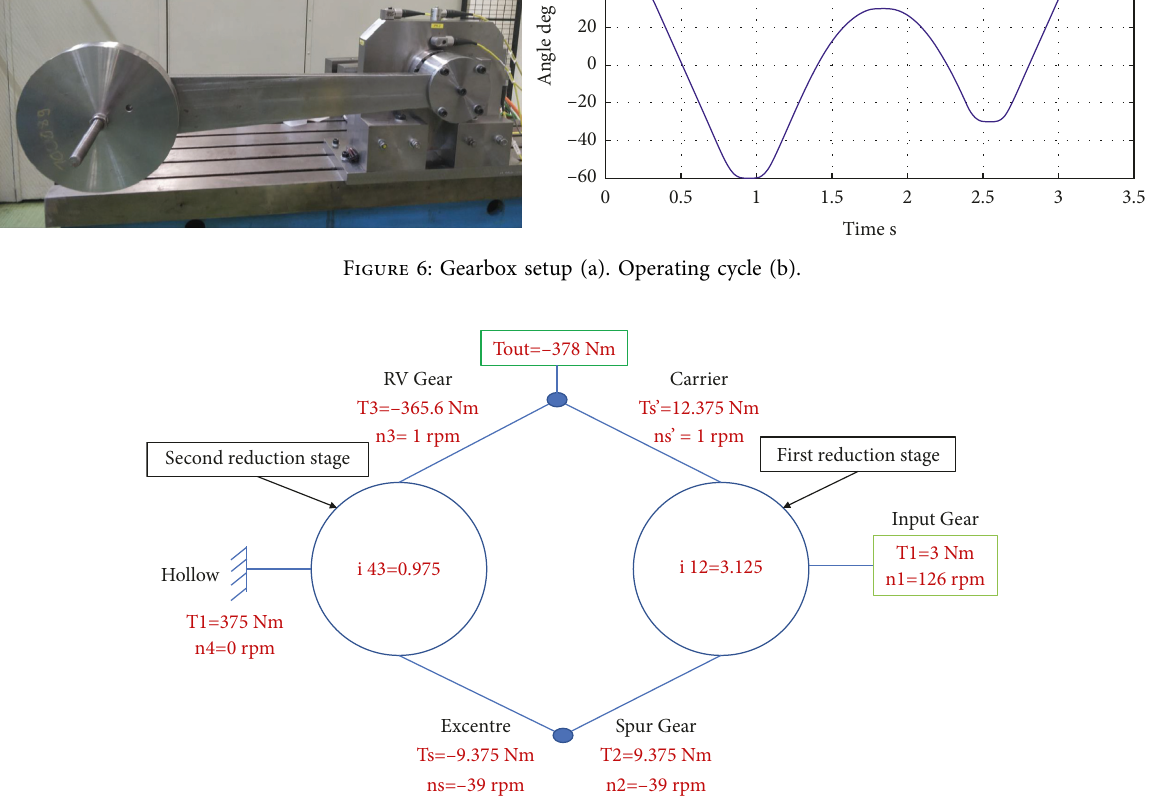
Figure 7: Willis equation for torque and velocity calculation on Nabtesco